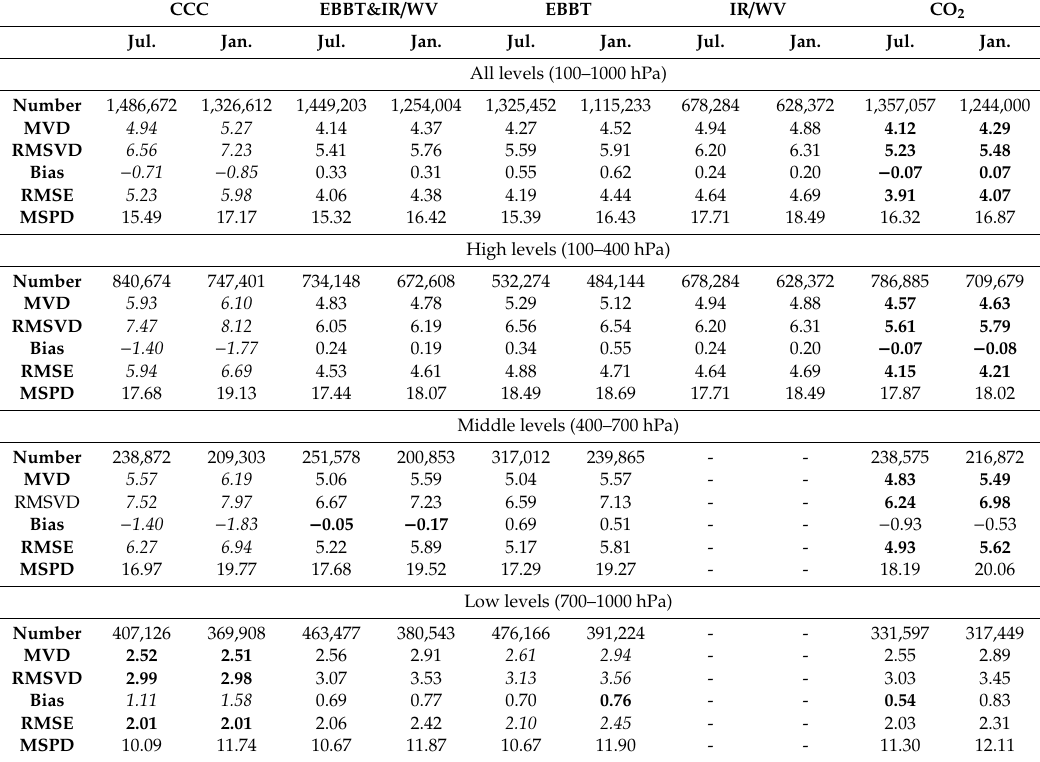
Table A3. Comparisons between GK-2A cloudy AMVs for CH13 and GDAPS over the full-disk area for July 2016 and January 2017. The CCC, EBBT, IR / WV intercept, CO 2 slicing methods, and the combination of EBBT and IR / WV intercept methods were used for producing GK-2A AMVs, considering QIF > 80. The best scores are in bold and the worst scores are in italics. CO 2 slicing method is best on average at all